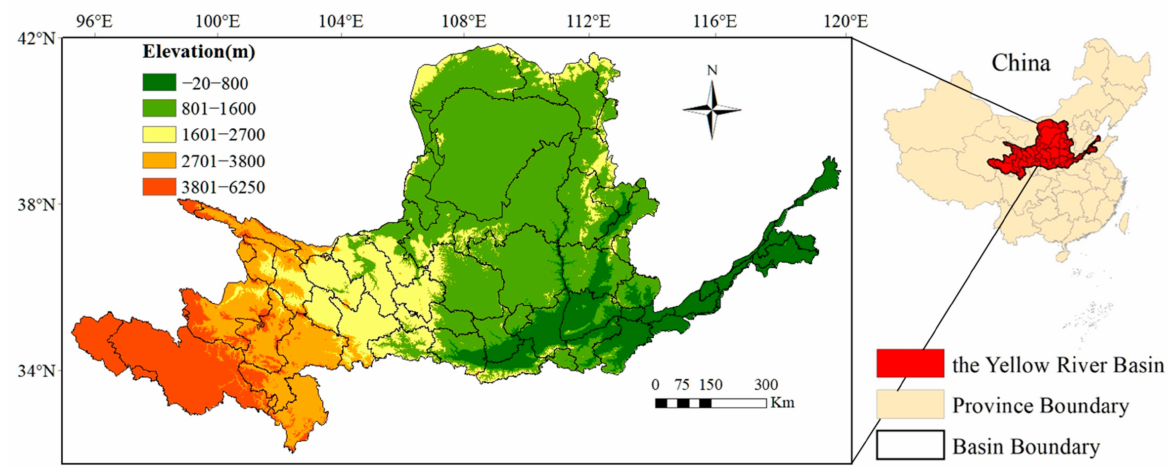
Figure 1. Topographic location of the Yellow River Basin,